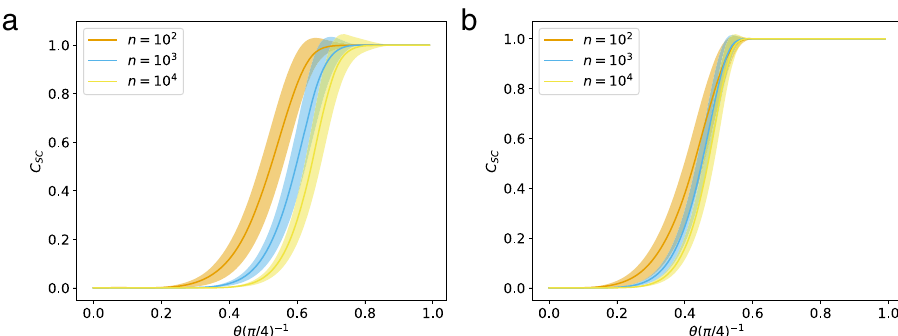
Fig. 9 The s - t concurrence as a function of entanglement strength for complex networks. The solid lines show the curves averaged over 100 network realizations and the bands represent one standard deviation. We calculate C st , the s - t concurrence, between two maximally separated nodes as a function of link weight, θ , for ( a ) Erd ő s--Rényi (ER) with k h i ¼ 4 and ( b ) Barabási--Albert (BA) networks with coordination number z = 2, calculated under the S 1 approximation.